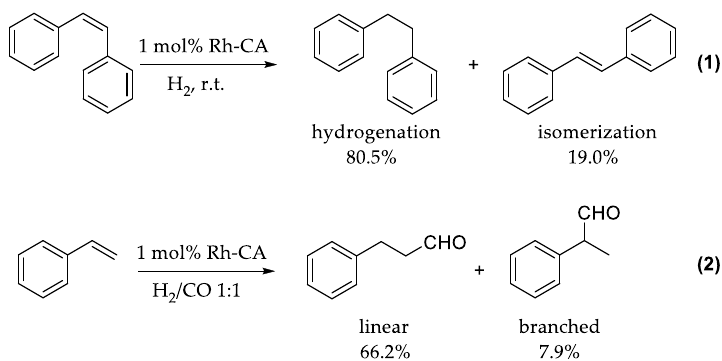
Figure 5. Hydrogenation and isomerization of cis-stilbene ( 1 ) and hydroformylation of styrene ( 2 ).